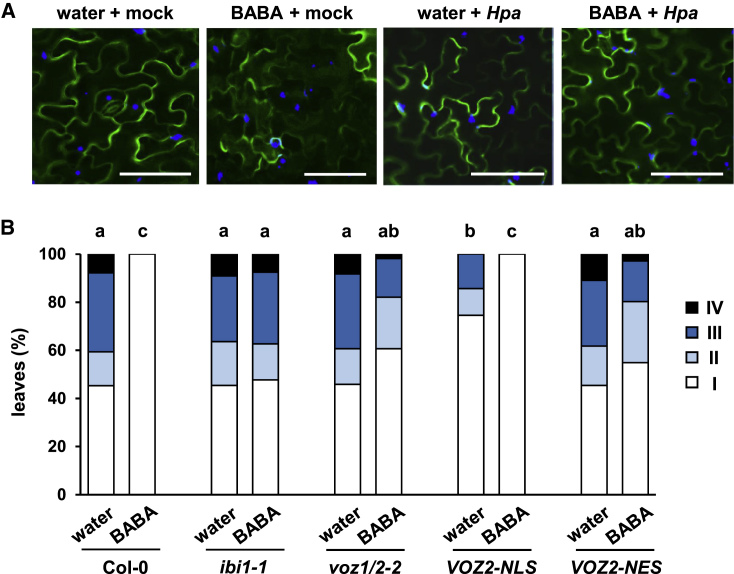
VOZ2 Is Predominantly Localized in the Cytoplasm but Requires Nuclear Localization for Its Contribution to BABA-IR against Hpa.(A) Epifluorescence microscopy of epidermal leaf cells reveals that GFP-VOZ2 is predominantly localized in the cytoplasm under all four experimental conditions, rather than the nucleus. Shown are merged fluorescence signals from DAPI-stained nuclei (blue) and GFP-VOZ2 (green). Two-week-old voz1/2-1 35S:GFP-VOZ2 plants were soil-drenched with 5 mg/l BABA or water and challenge-inoculated with Hpa or water (mock) 2 days later. Samples for DAPI staining and epifluorescence microscopy were taken at 2 dpi. Scale bars, 50 μm.(B) BABA-IR against Hpa requires nuclear localization of VOZ2. Two-week-old Col-0, voz1/2-2, and voz1/2-1 plants complemented with VOZ2 fused to a nuclear localization signal (VOZ2-NLS) or VOZ2 fused to nuclear exportation sequence (VOZ2-NES), were soil-drenched with water or 5 mg/l BABA and inoculated with Hpa 2 days later. Disease progression was analyzed in trypan blue-stained leaves at 5 dpi by assigning leaves to different Hpa colonization classes (Supplemental Figure 6). Different letters indicate significant differences in class distributions (Fisher's exact tests + FDR; p < 0.05; n = 60–150 leaves).